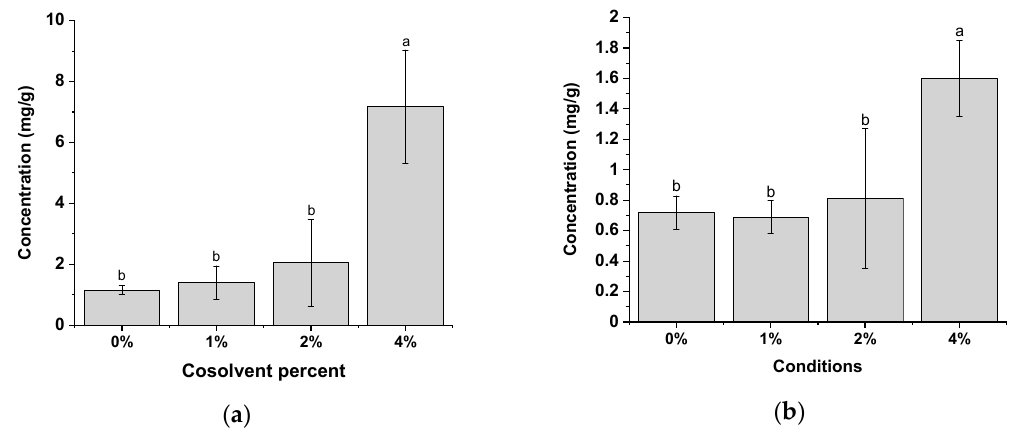
Figure 3. Determination of the levels of ( a ) Formononetin (mg/g); and ( b ) Kaempferol (mg/g) by HPLC-DAD in the extracts of red propolis obtained with the presence of different cosolvent percentages and using CO 2 as a supercritical fluid (50 °C; 250 bar; CO 2 flow rate of 6 g/min; S/F 131). Bars with the same letter are not significantly different ( p < 0.05) according to Tukey’s test at the 95% confidence level.